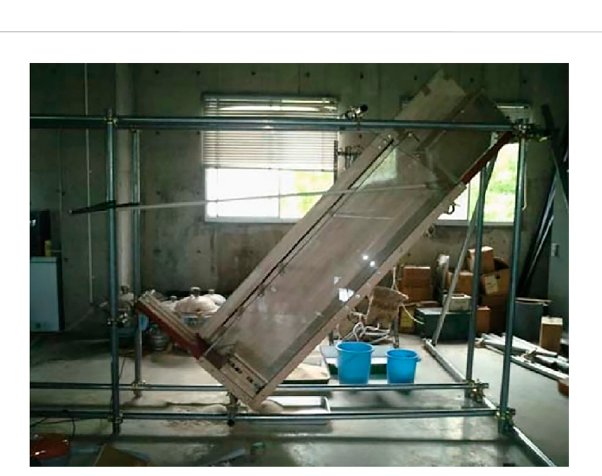
FIGURE 8 Laboratory test diagram of debris fl ow (Moriguchi et al.